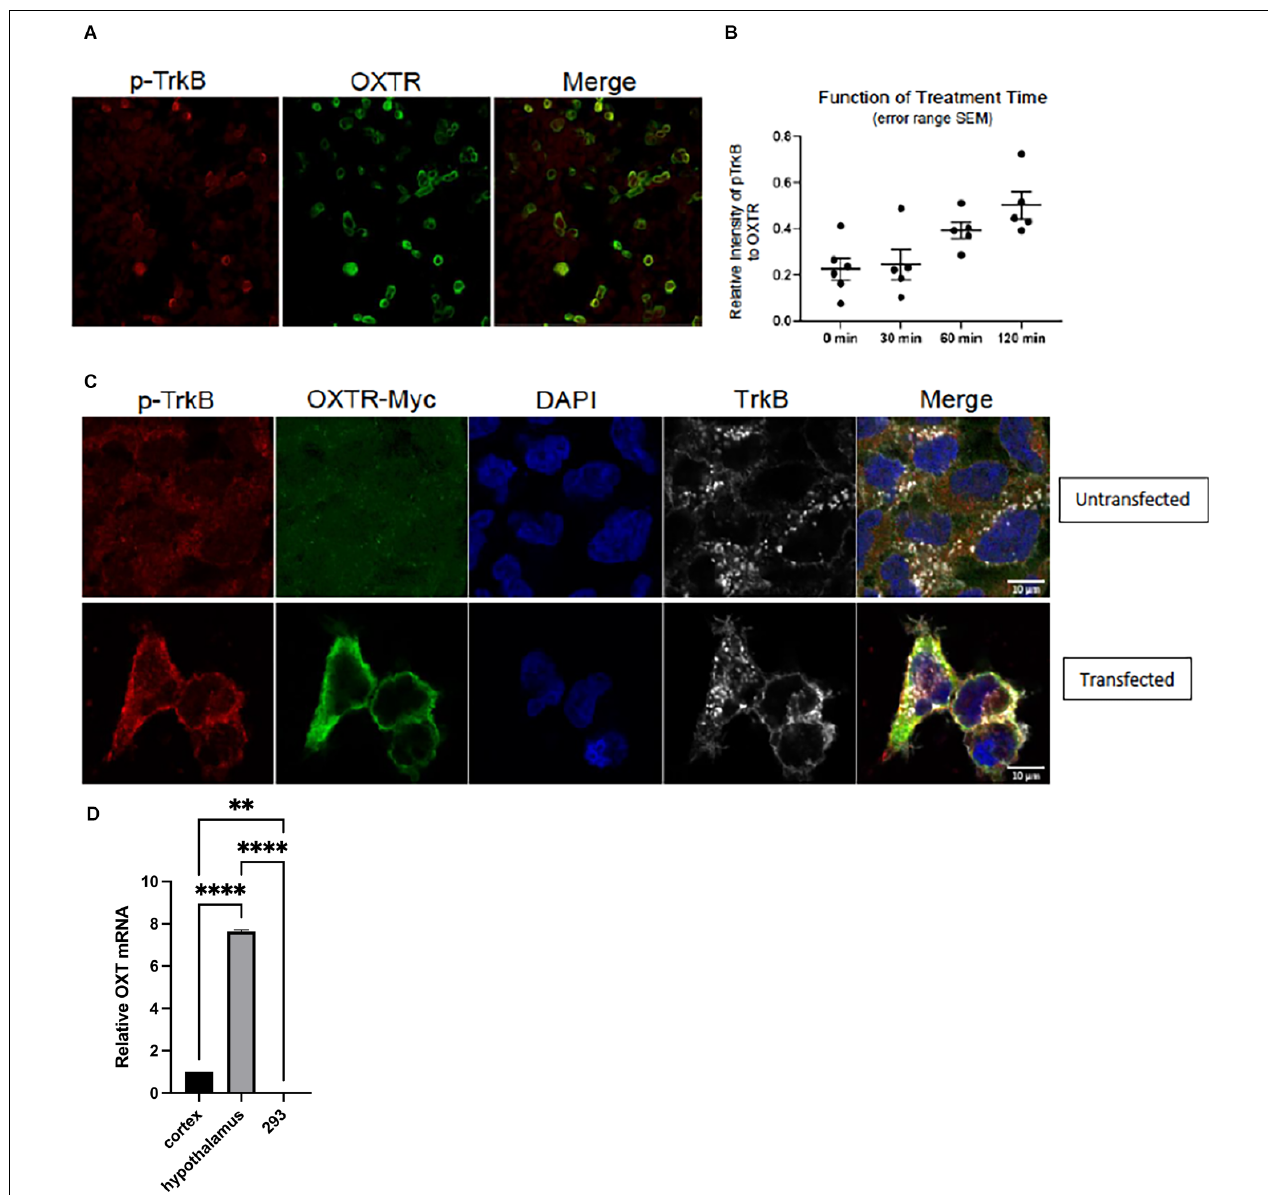
FIGURE 4 | Transfection of OXTR plasmid in HEK-293-TrkB cells produces increased phospho-TrkB. Immunocytochemistry of cells with pTrkB in red transfected with myc-tagged OXTR in green. Co-expression of OXTR led to activation of TrkB. Next day, cells were serum starved for 2 h and then treated with 1 µ M oxytocin. Images were taken at 120 min of oxytocin treatment. (A) Left panel, staining with phosphor-TrkB Y816 Cell Signaling 4168 antibody (red). Middle panel, staining with myc-tagged OXTR (green; 18). Right panel, Merge of pTrkB and OXTR. (B) Images from time points of 0 (no oxytocin), 30, 60 and 120 min were collected with matching laser intensities and detector responses. The results were quantitated by Image J analysis as a ratio of Red (pTrkB) to Green (OXTR) staining. The results were plotted in GraphPad Prism 8.2.0. Zeiss CZI files were imported into Image J using Bio-formats 6.5.0. (C) Upper panel, untransfected HEK293/TrkB cells. Staining with antibodies against p-TrkB (Cell Signaling 4168); OXTR-myc, DAPI and total TrkB (R & D System AF1494) is shown. Lower panel, HEK293/TrkB cells are transfected with 0.5 µ g/well myc-tagged OXT receptor plasmid for 16 h. The effect of OXTR expression on TrkB activation in cells was evaluated by detecting the levels of p-TrkB (Y816), left lower panel and Merge. (D) Negligible oxytocin ligand RNA is detected in HEK293-TrkB cells. Expression of oxytocin ligand RNA is measured by RT-qPCR from total RNA isolated from cortex, hypothalamus, and HEK293-TrkB cells. Relative expression levels of OXT mRNAs was normalized to actin, statistical calculations were made using one-way ANOVA with multiple comparisons (Prism